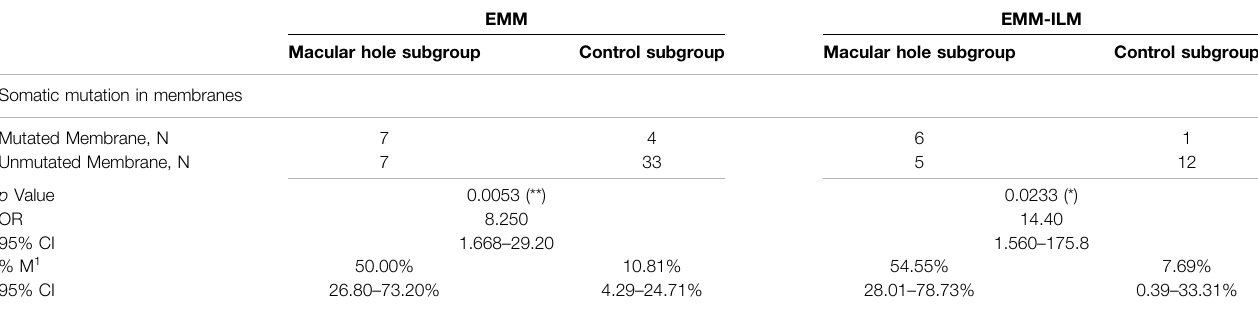
TABLE 4 | Association of somatic mutation at the MDM2 T309G locus and macular holes in EMM cases. EMM EMM-ILM Macular hole